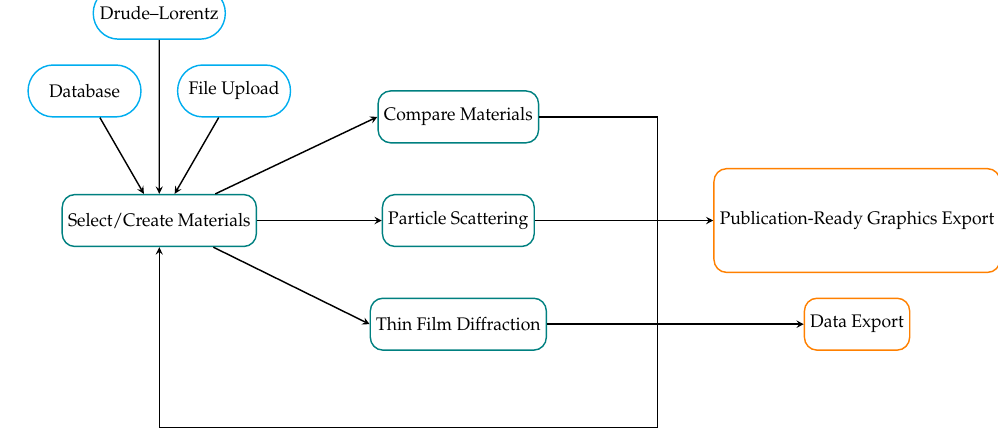
Figure 2. PMCloud’s basic workflow. Blue indicates possible input channels, green represents the current analysis “tabs”, and orange marks possible export